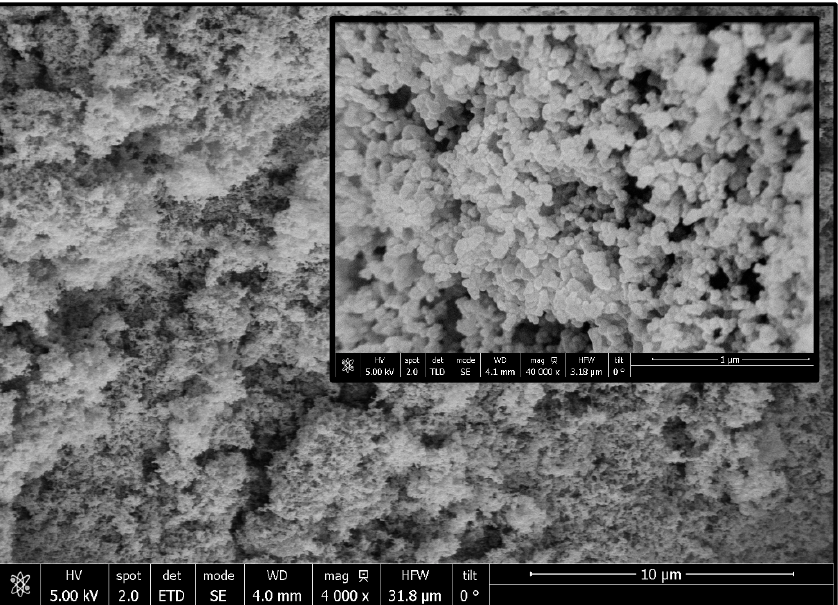
Figure 4. SEM image of a scaffold produced by run 2. A zoomed image is included at the top right corner.